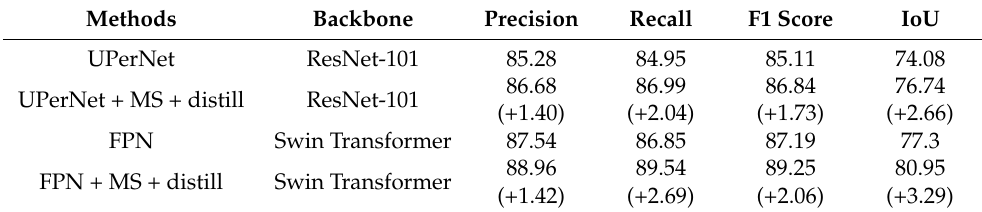
Table 5. Results of multiscale distillation applied to different methods.